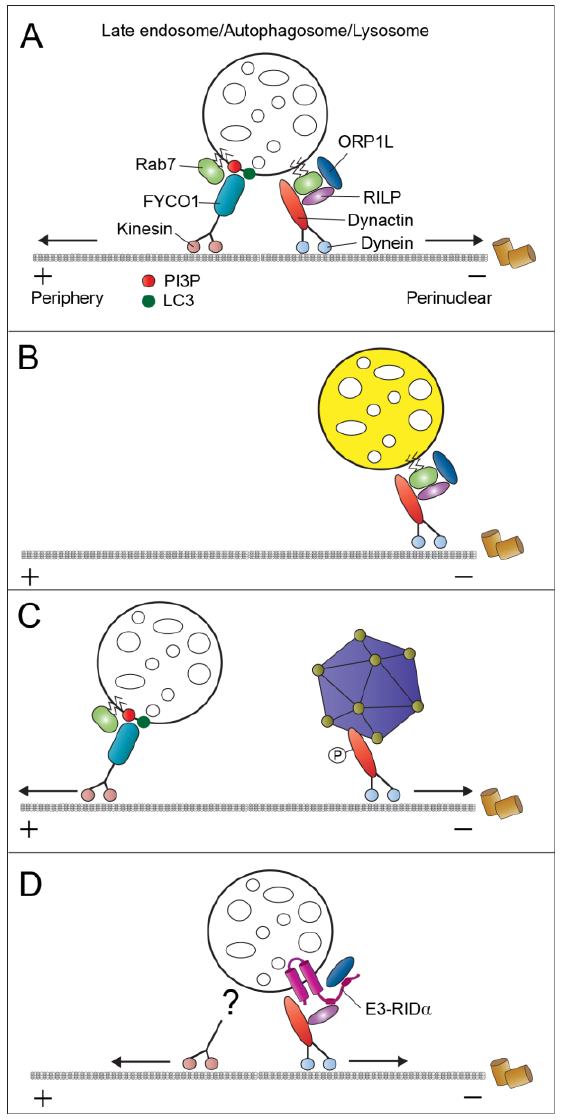
Figure 4. Mechanisms regulating dynamic LE/Lys motility. ( A ) Rab7 regulates bidirectional motility via engagement with kinesin and dynein motors through its effector proteins FYCO and RILP/ORP1L. ( B ) Excessive cholesterol causes LEs to become immobilized through stable recruitment of dynein motors. ( C ) Adenovirus-activated protein kinase A (PKA) phosphorylates light intermediate chain 1 (LIC1) causing dynein motors to shift from LEs to viral capsids. ( D ) RID α reconstitutes RILP-dependent recruitment of dynein motors and uncouples LE from cholesterol regulation by alleviating the sterol-sensing activity of ORP1L. Mechanism mediating kinesin recruitment to RID α -positive vesicles is currently unknown. “ + ”, plus end-directed; “ − ”, minus end-directed.